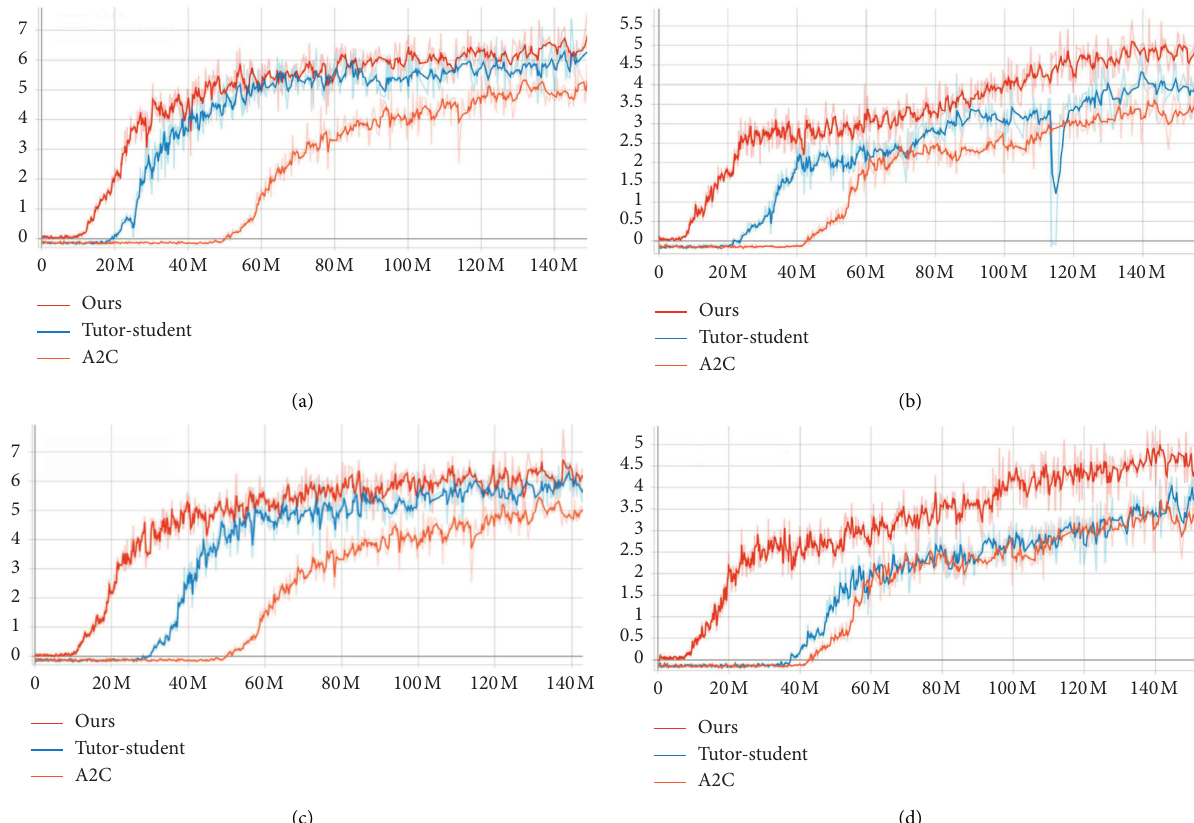
Figure 7: Average reward curves of ours, tutor-student, and A2C models in transfer navigation. (a) Transfer navigation from the two- bedroom maze to the one-bedroom maze. (b) Transfer navigation from the two-bedroom maze to the four-bedroom maze. (c) Transfer navigation from the three-bedroom maze to the one-bedroom maze. (d) Transfer navigation from the three-bedroom maze to the four- bedroom